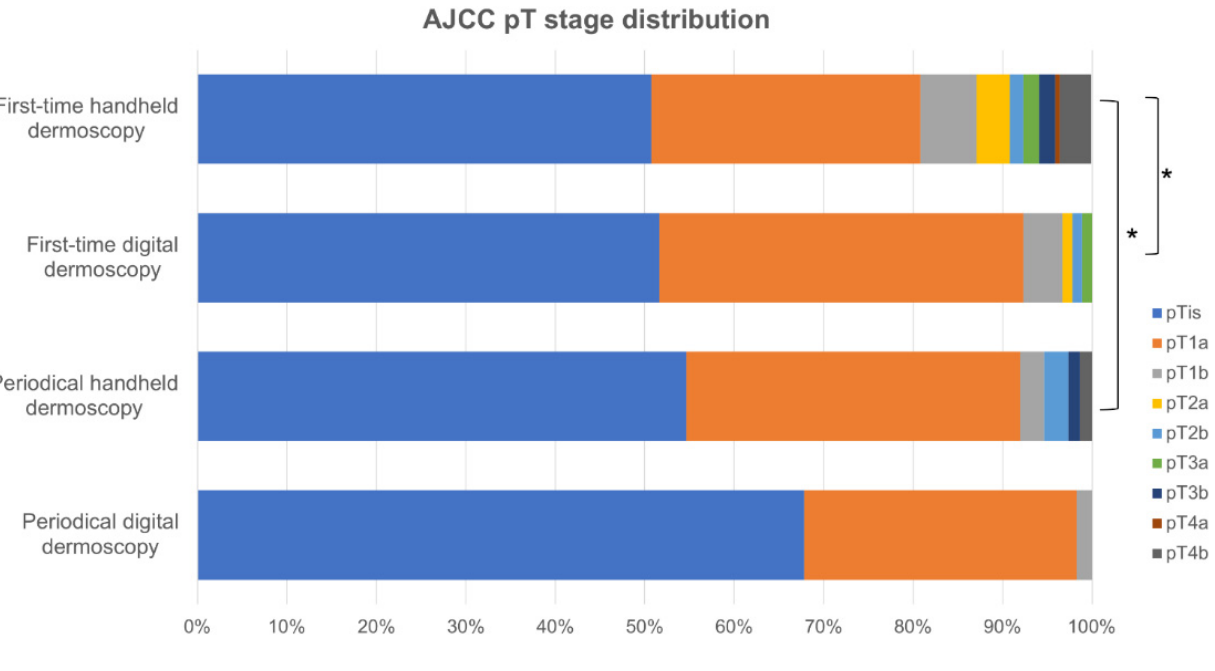
Figure 3. Distribution of pT stages between the groups. * p < 0.05.